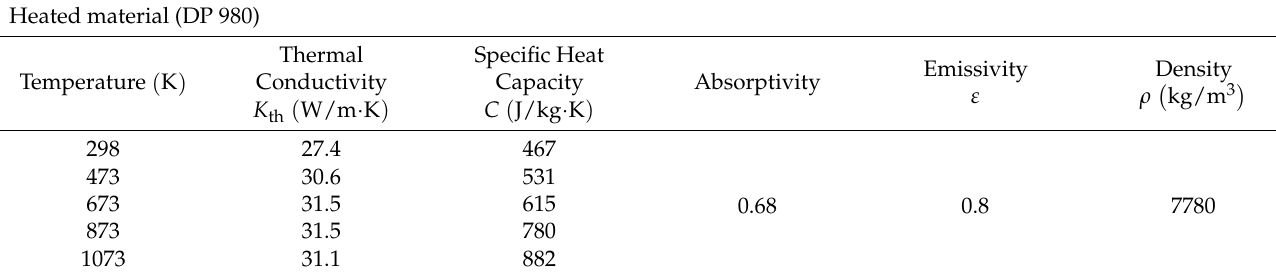
Figure 7. FEM modeling and heating condition. Table 2. Parameters of the IR lamp. Table 3. Properties of the heated